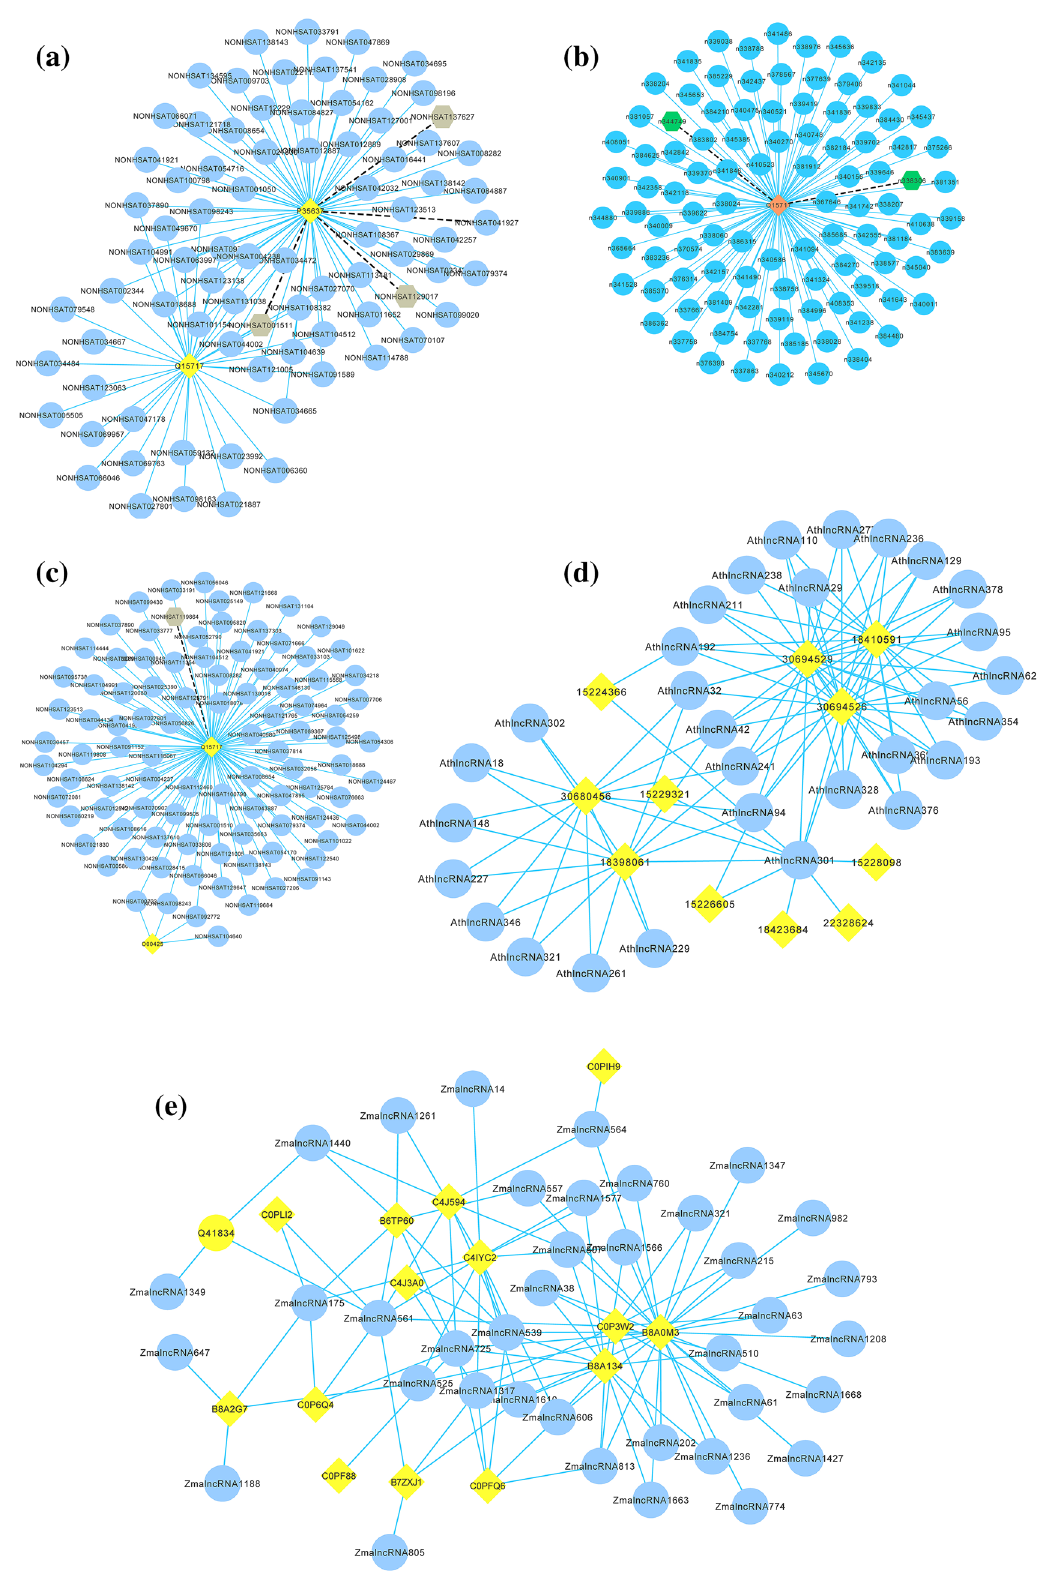
Figure 1. The predicted top 100 LPIs on the five datasets (a) Dataset 1, (b) Dataset 2, (c) Dataset 3, (d) Dataset 4, (e) Dataset